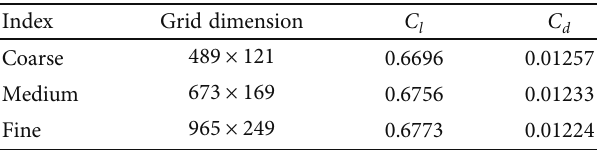
Figure 6: Lift augmentation due to injection on the lower surface of NACA0018 airfoil. Table 1: RAE 2822 the grid convergence results.